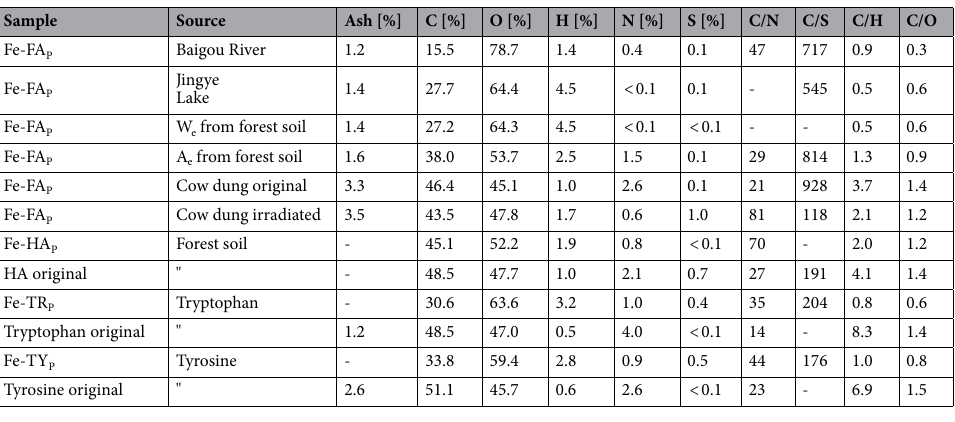
Table 1. Elemental composition (C, O, N, H, S) (moisture and ash free) and atomic ratios (C/N, C/S, C/H and C/O) of Fe ‒ fulvic acid precipitates (Fe ‒ FA P ) and Fe ‒ humic acid precipitates (Fe ‒ HA P ) from river, lake, soil, original and irradiated cow dung samples, Fe ‒ tryptophan precipitates (Fe ‒ TR P ) and Fe ‒ tyrosine precipitates (Fe ‒ TY P